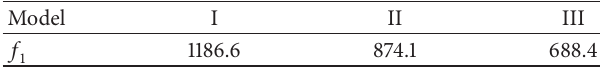
Table 1: First natural frequencies